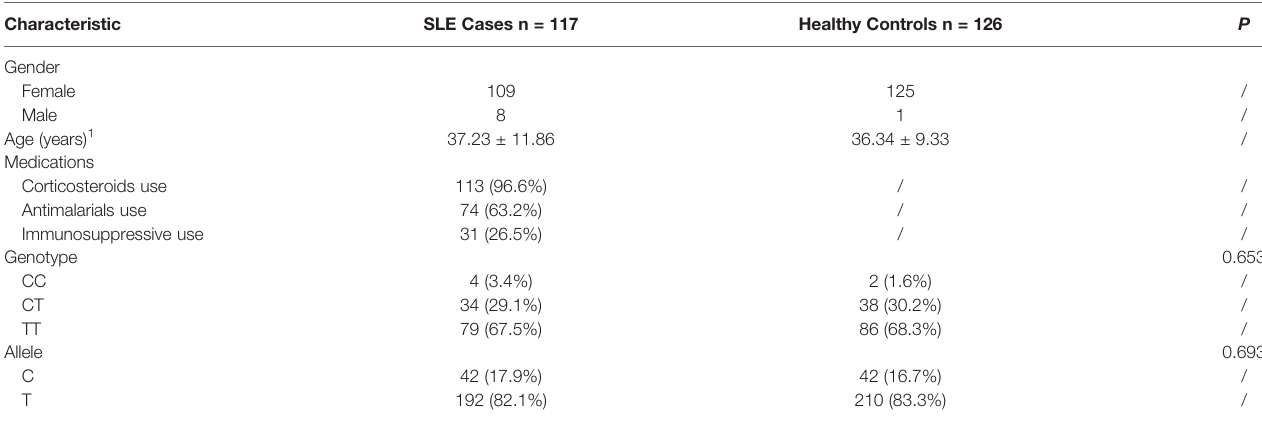
TABLE 1 | Demographic characteristics of the study